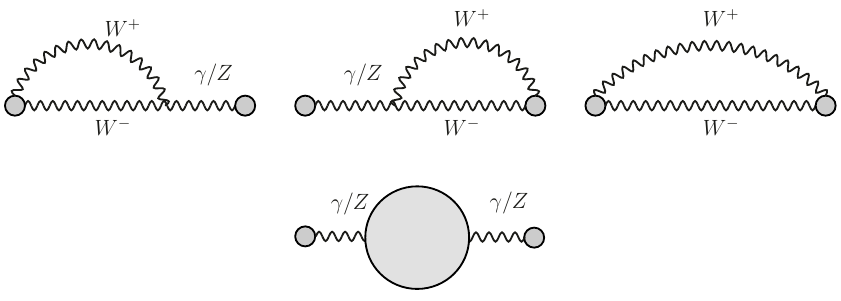
Figure 10 . Wilson line and self-energy type Feynman diagrams contributing to the narrow reso- lution jet